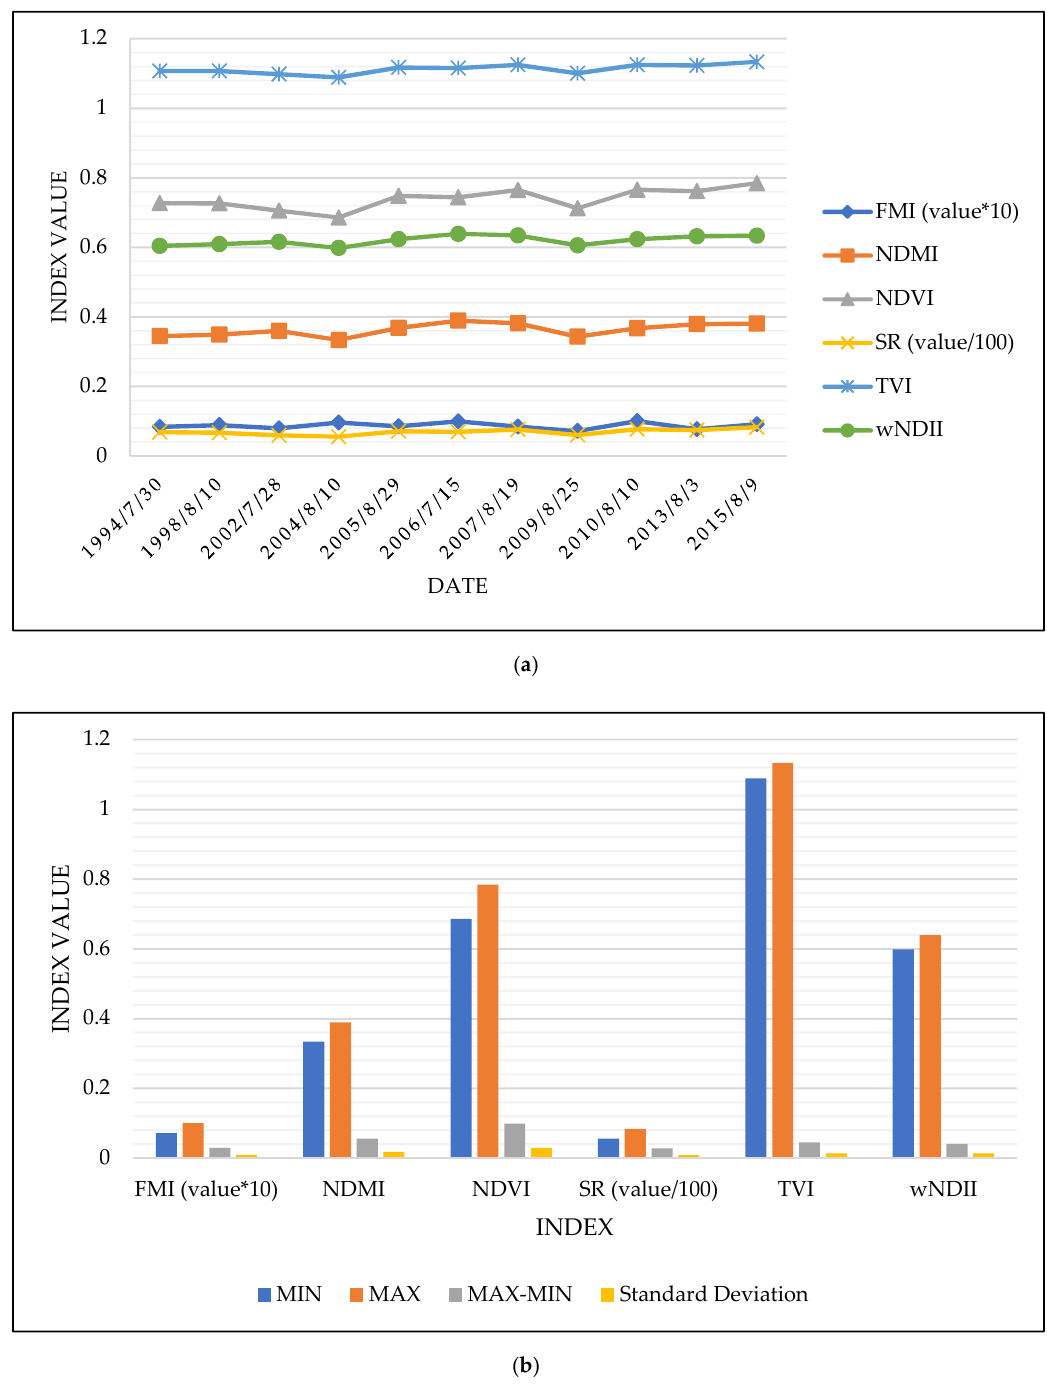
Figure 12. Time series of the locality with minimal disturbance ( a ); and the statistical information ( b ) (Locality 8) (Source: Own work).